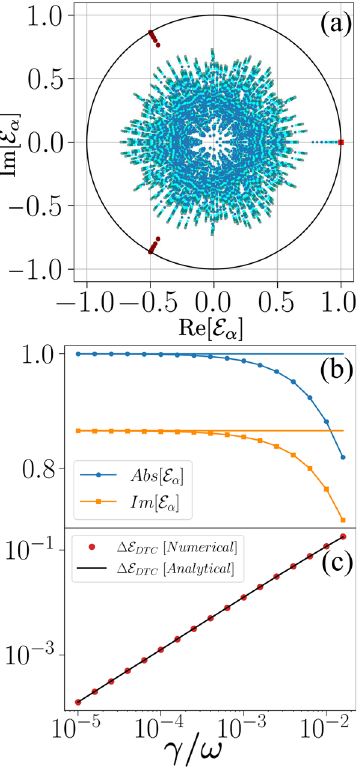
Fig. 2 Spectrum of the Floquet map. a All the eigenvalues of the Floquet map U F , the red dots near the unit-circle in the complex plane (not on the real axis) are the discrete time crystal (DTC) eigenvalues. b Absolute (Abs) (cid:9) (cid:10) values Abs ½ E DTC (cid:3) and the imaginary (IM) part Im E DTC of the DTC eigenvalues as a function of dimensionless system-lead coupling γ / ω . Blue horizontal line represents the peripheral spectrum for which j E α j ¼ 1, the (cid:9) (cid:10) orange horizontal line represents Im E DTC for γ = 0. c Deviation Δ E DTC of the DTC eigen-value E DTC from the eigenvalue of the Floquet steady state, E γ / ω on a log-log scale. Slope of the straight-line is 0.15. (cid:6) (cid:7) FSS as a function of The straight-line corresponds to the function Δ E DTC ¼ 1 (cid:2) e (cid:2) 2 γ T (cid:6) 2 γ T , where T = 0.1 μ s [see Eqs. S(18) – S(22)].